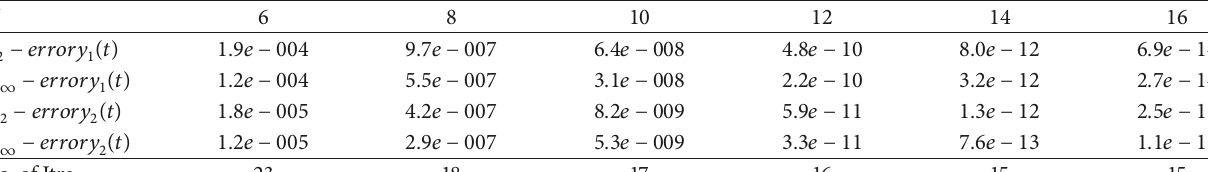
Table 3: The 𝐿 2 and 𝐿 ∞ errors for Example 3 when 𝑁 = 16 .